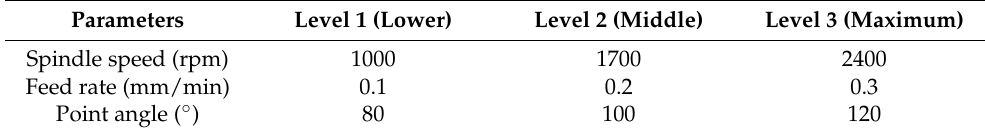
Table 1. Levels of drilling parameters.